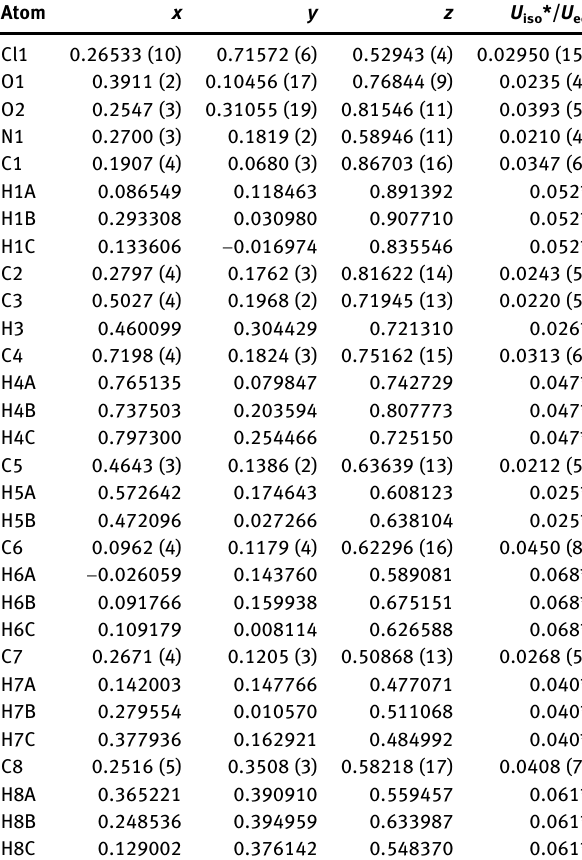
isotropic displacement parameters (Å 